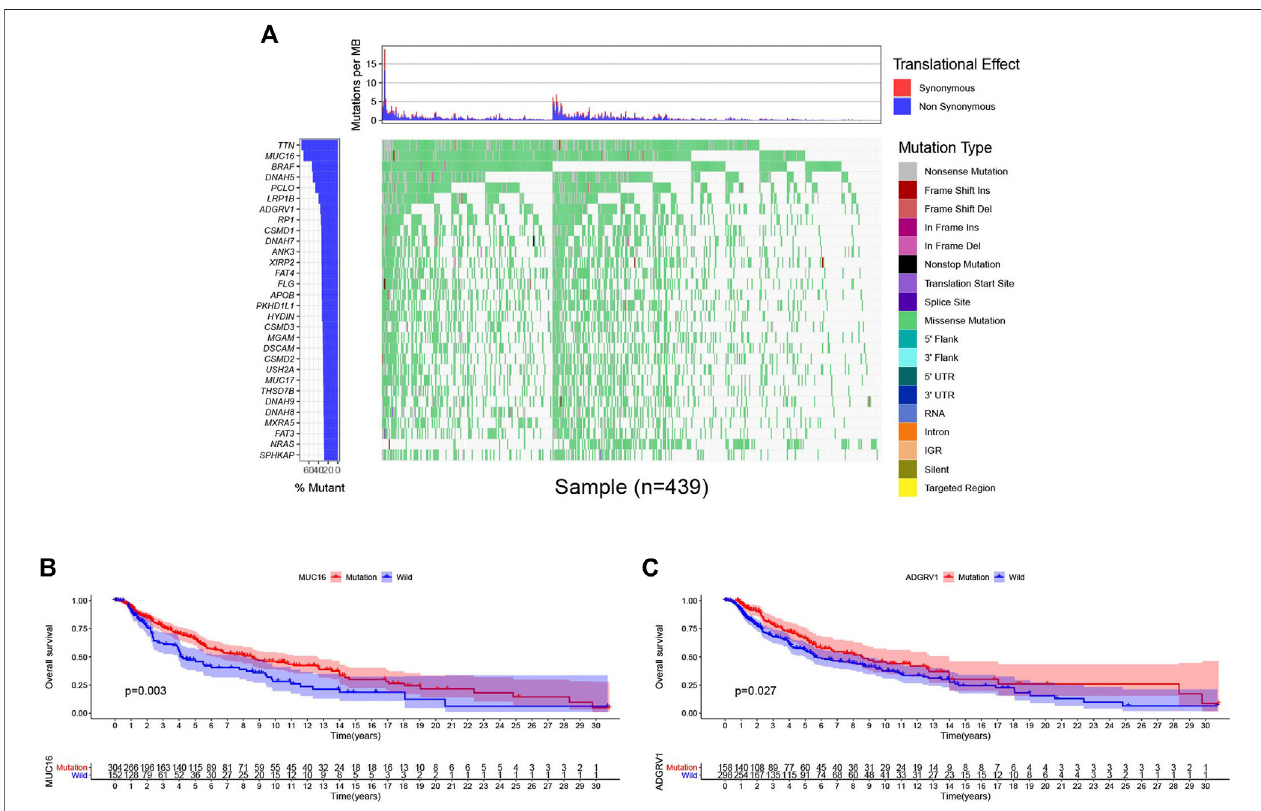
FIGURE7| Genomicalterationsandclincalimplicationsincutaneousmelanoma. (A) Thewaterfallplotsoftop30mutatedgenesinTCGAdatabase. (B – C) Kaplan- Meier survival analysis for MUC16 (B) , ADGRV1 (C) mutated genes.